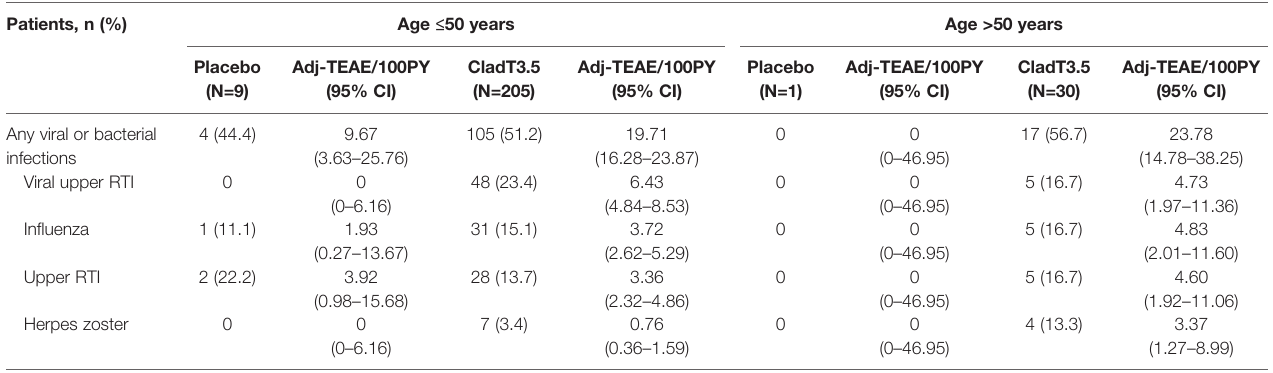
TABLE 4 | TEAEs of viral and bacterial infections in years 1 and 2 among patients who reported Grade ≥ 3 lymphopenia. Patients, n (%)